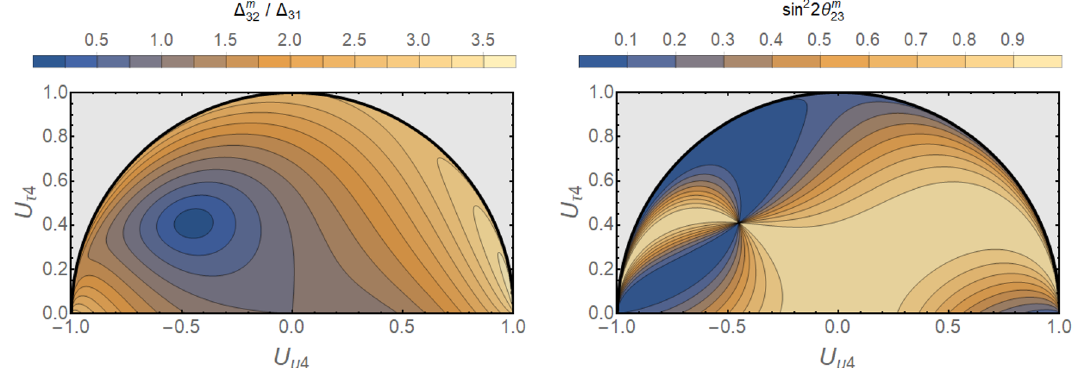
Figure 3 . Effective parameters ∆ m / ∆ 31 (left) and sin 2 2 θ m (right) as a function of real values 32 23 of U µ 4 and U τ 4 , for a neutrino energy of 20 GeV. Here, ∆ m 2 = 2 . 5 × 10 − 3 eV 2 , s 2 = 0 . 57 , 31 23 and a matter density of 8.5 g/cm 3 with a ratio N n /N e = 1 . 08 were assumed. The resonance and antiresonance described in equations (3.16) and (3.17) are visible on the right as regions of maximum and minimum sin 2 2 θ m . At the point where they seem to meet, a pole exists where ∆ m → 0 and 23 32 sin 2 2 θ m becomes 23